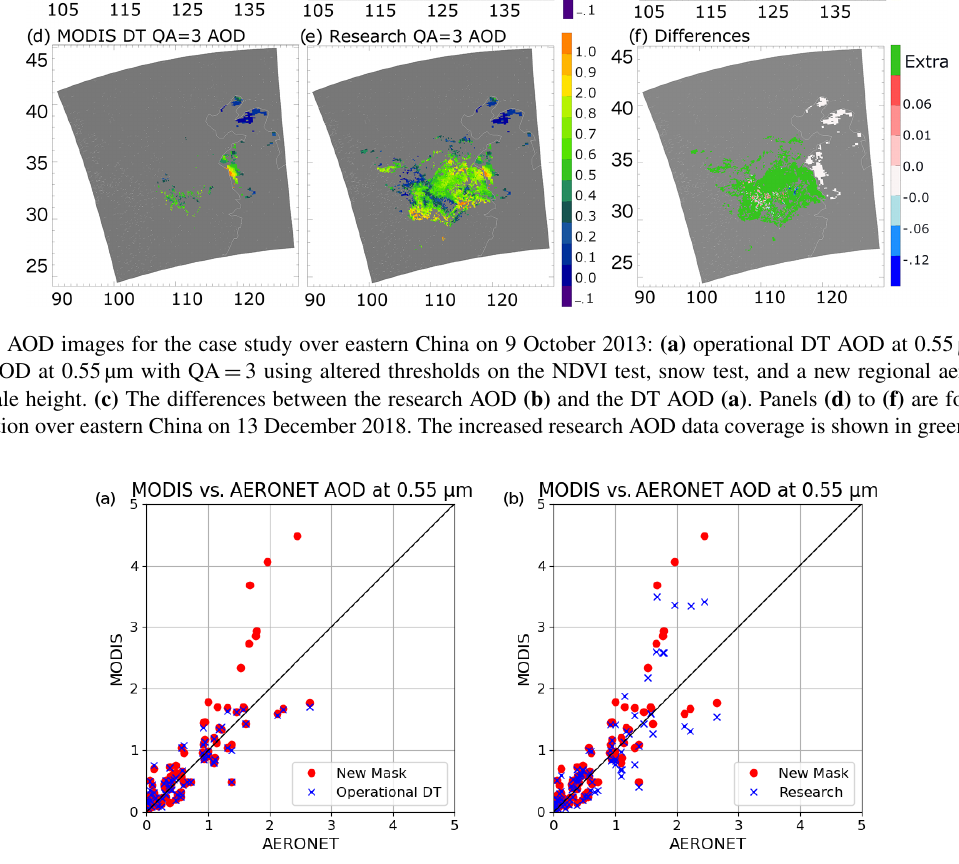
Figure 9. Comparisons of the MODIS DT AOD at 0.55µm against collocated AERONET observations during January, February, and March 2013 over China. Three data sets are used: operational DT AOD, an intermediate AOD retrieved using the same LUT as the operational DT but with modified masking (New Mask), and AOD retrieved with the full regional research algorithm (Research). (a) operational DT AOD overlay New Mask AOD; (b) Research AOD overlay New Mask